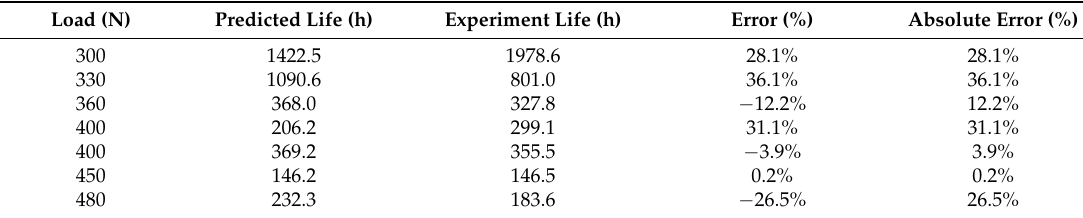
Table 5. The prediction results of 16Mo3 by the Monkman-Grant Method.